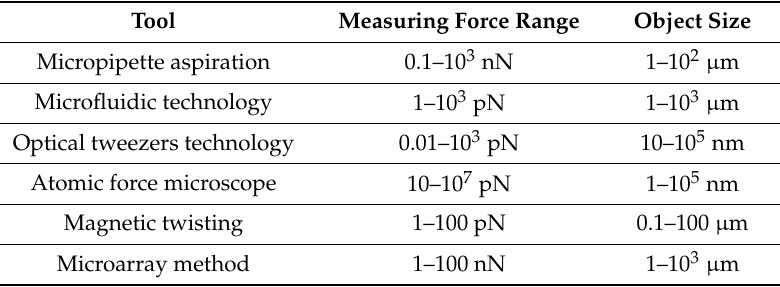
Table A2. Characteristics of measurement